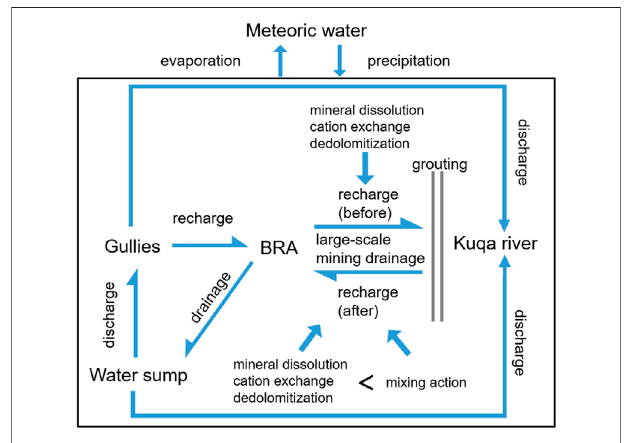
FIGURE 14 | Origin and evolution of hydrogeochemistry and hydrogeology in the